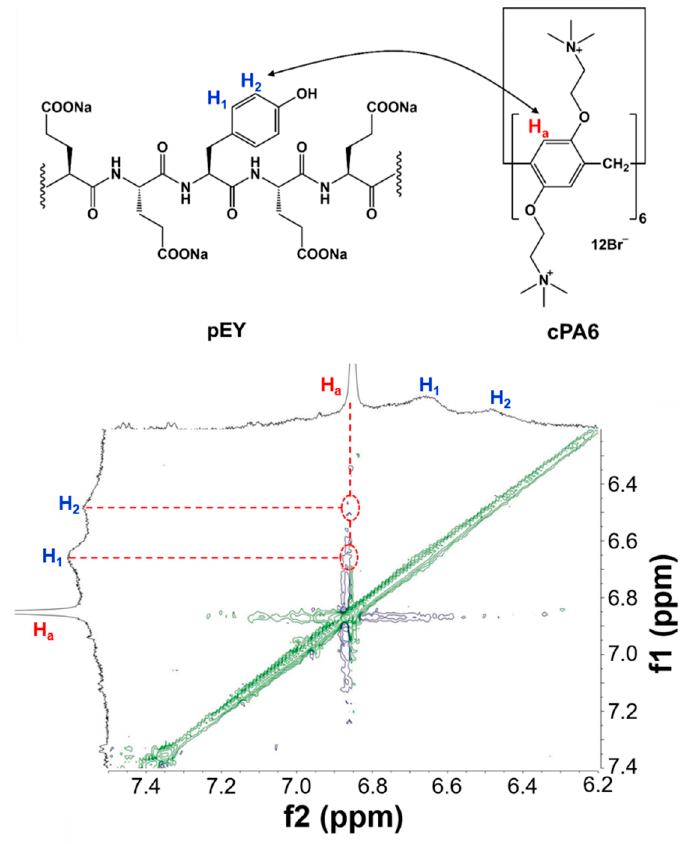
Figure 4. Selected area of the 2D 1 H- 1 H nuclear overhauser effect spectroscopy (NOESY) spectrum of cPA6/pEY (500 MHz, Tris-DCl buffer prepared with D 2 O, 25 °C). [cPA6] = 2.0 mM, [pEY] = 2.0 mM.